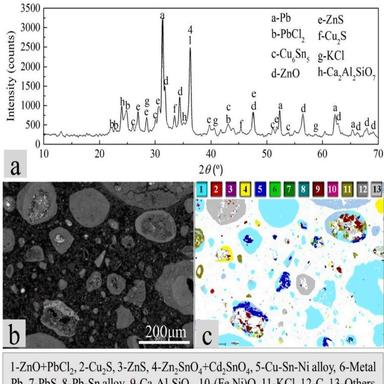
Characteristics of the raw materials: (a) XRD pattern; (b, c) SEM backscatter grayscale diagram and pseudo-color picture of the mineral phase at low magnification (300 × ).